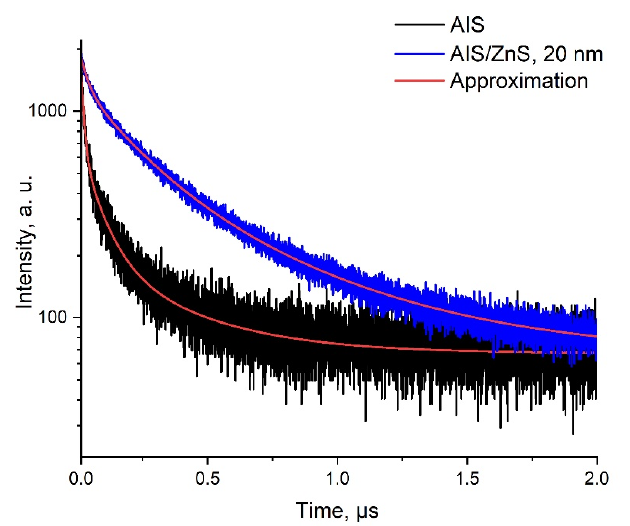
Figure 3. Fluorescence decay curves of AIS cores QDs and fluorescence decay curves of AIS/ZnS QDs 20 nm. Triexponential function approximation: f ( x ) = A 1 ∗ e − τ 1 / t + A 2 ∗ e − τ 2 / t + A 3 ∗ e − τ 3 / t Table 2. Results of QDs AIS and AIS/ZnS the fluorescence decay kinetics.